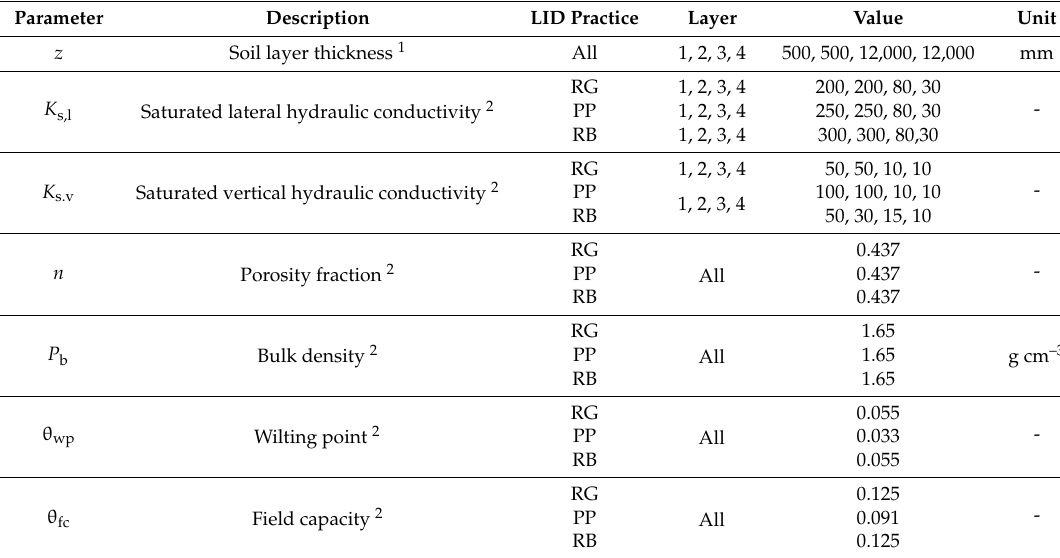
Table 6. Soil parameter values used in the LID practice scenarios. RG: Rain Garden, PP: Permeable pavement, and RB: Riparian Buffer.